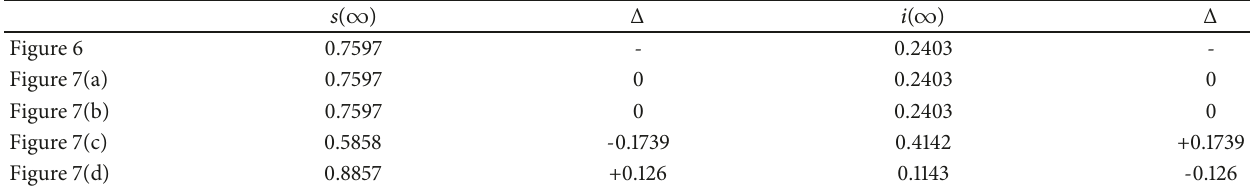
Table 4: Infecting investors and immune investors scale changes of SCIR investor risk contagion model in the stock market under different mechanism probability